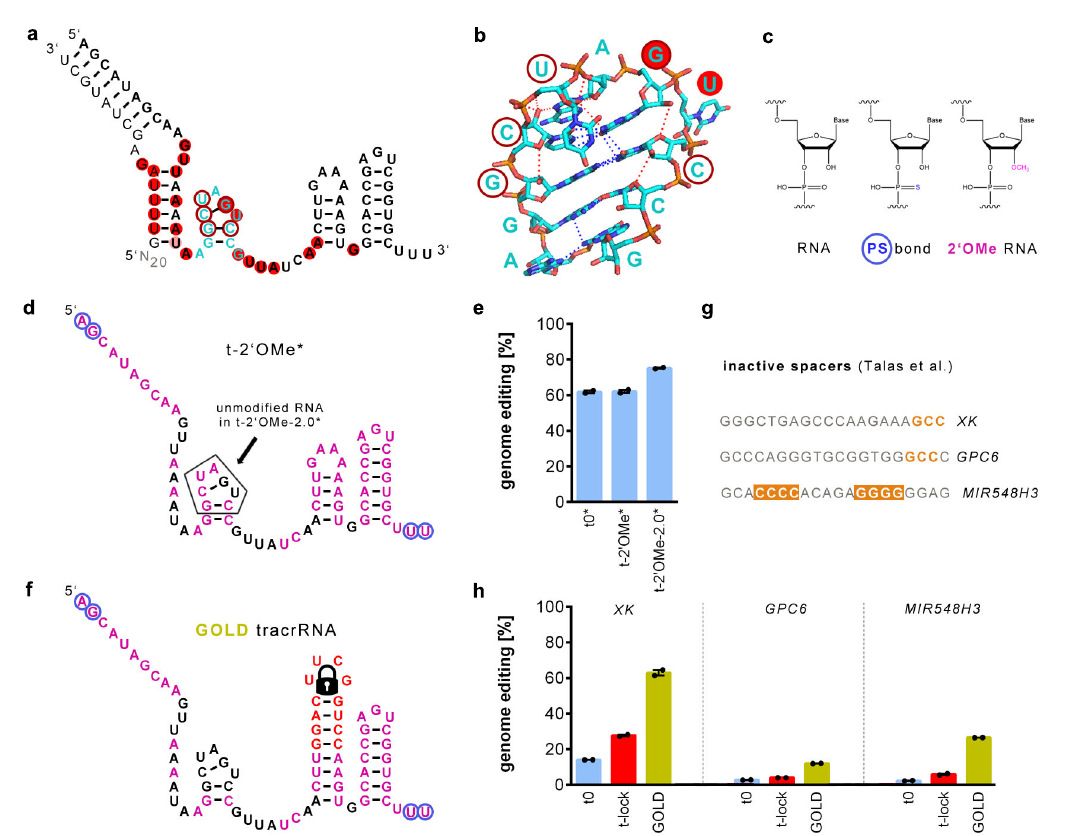
Fig. 2 Optimization of chemical modi fi cations of the gRNA. a Nucleotides of the gRNA (hybridized crRNA:tracrRNA) of which the 2 ’ OH interacts with Cas9 or with residues of the nexus (cyan) are underlaid in red or circled in dark red, respectively. The residue underlaid in rose interacts with both Arg75 and Tyr52 of the bridge helix that modulates DNA cleavage. b Close-up of the crystal structure of the nexus and interacting residues adapted from NDB: 5F9R. Polar interactions are shown as dotted lines and those of 2 ′ OH residues are shown as dotted red lines. c Single RNA nucleotide structure and chemical modi fi cations. d Chemical modi fi cations of the tracrRNA with phosphorothioate bonds and 2 ’ OMe modi fi cations (t-2 ′ OMe*). The nexus loop of t- 2 ′ OMe-2.0* only contains unmodi fi ed RNA nucleotides (colored according to c). t0* only contains phosphorothioate bonds. e Genome editing ef fi ciency of different chemically modi fi ed tracrRNAs hybridized with a medium cleavage crRNA electroporated into Cas9 expressing 409-B2 iCRISPR (hiPSCs). f Structure and chemical modi fi cations of the genome editing optimized locked design (GOLD) tracrRNA. g Spacer sequences of previously described inactive gRNAs. Putative cleavage-inhibiting motifs are highlighted orange. h Genome editing ef fi ciency of normal tracrRNA (blue), t-lock tracrRNA (red), and GOLD tracrRNA (gold) hybridized with crRNAs from g after electroporation into Cas9 expressing 409-B2 iCRISPR hiPSCs. Independent biological replicates ( n = 2) are depicted by black dots and the error bars show the SEM. Source data are provided as a Source Data fi